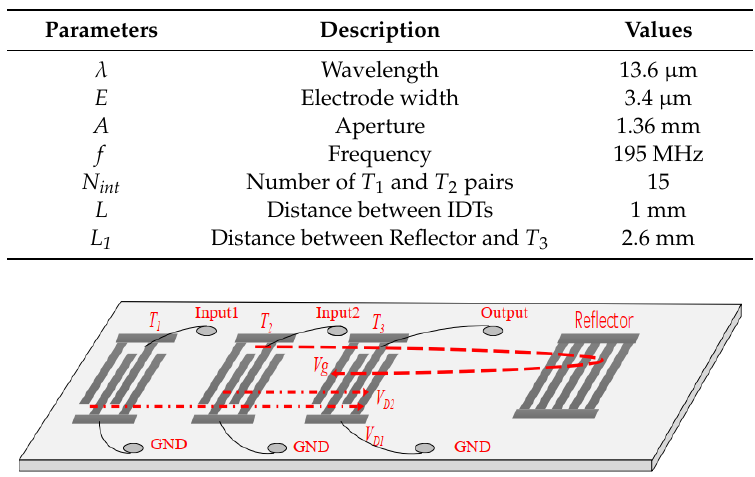
Figure 2. The structure of the SAW device for extraction of reflection coefficient.